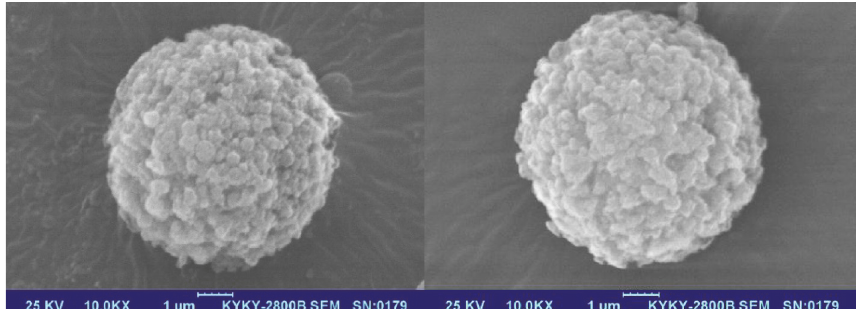
Table 1: Elemental analysis results of P GMA